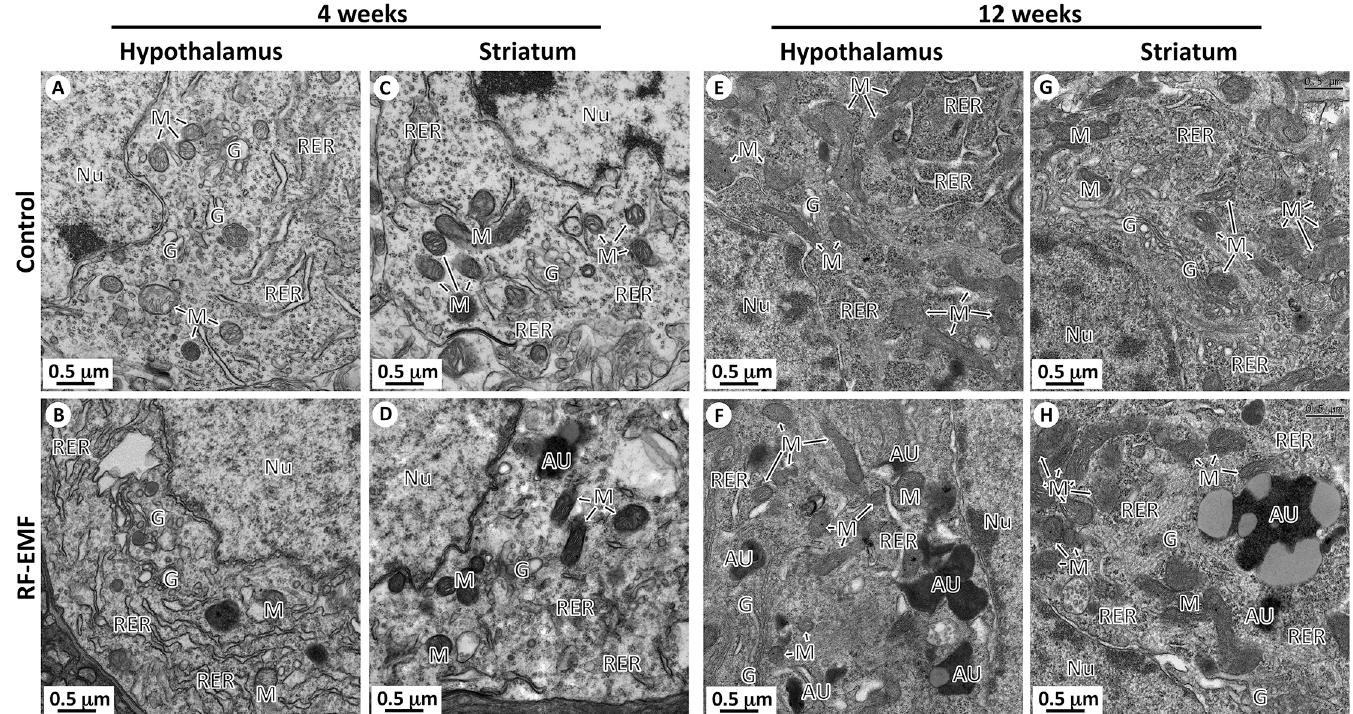
Fig 4. Comparison of intracellular organelles in neuron of hypothalamus and striatum between control and radiofrequency-exposed mice. (A-D). Representative TEM micrographs of neuronal cell body in hypothalamus and striatum were acquired from control mice and radiofrequency-exposed (4 weeks) mice, respectively. Comparative images showing structural indifference of intracellular organelles between control mice and radiofrequency-exposed mice in neuronal cell body of hypothalamus (A vs. B) and striatum (C vs. D). (E-H) Representative TEM micrographs of neuronal cell body in hypothalamus and striatum were acquired from control mice and radiofrequency-exposed (12 weeks) mice, respectively. In radiofrequency-exposed mice during 12 weeks, many autophagy (AU in F and H) were observed in neuronal cell body of hypothalamus (F) and striatum (H) in difference with that of sham control (E and G). However, most of the mitochondria (M), rough endoplasmic reticulum (RER), and Golgi apparatus (Ga) were maintained the structural integrity as similar with that of control mice. Abbreviations are: Nu, nucleus; M, mitochondria; RER, rough endoplasmic reticulum; Ga, Golgi apparatus and AU,